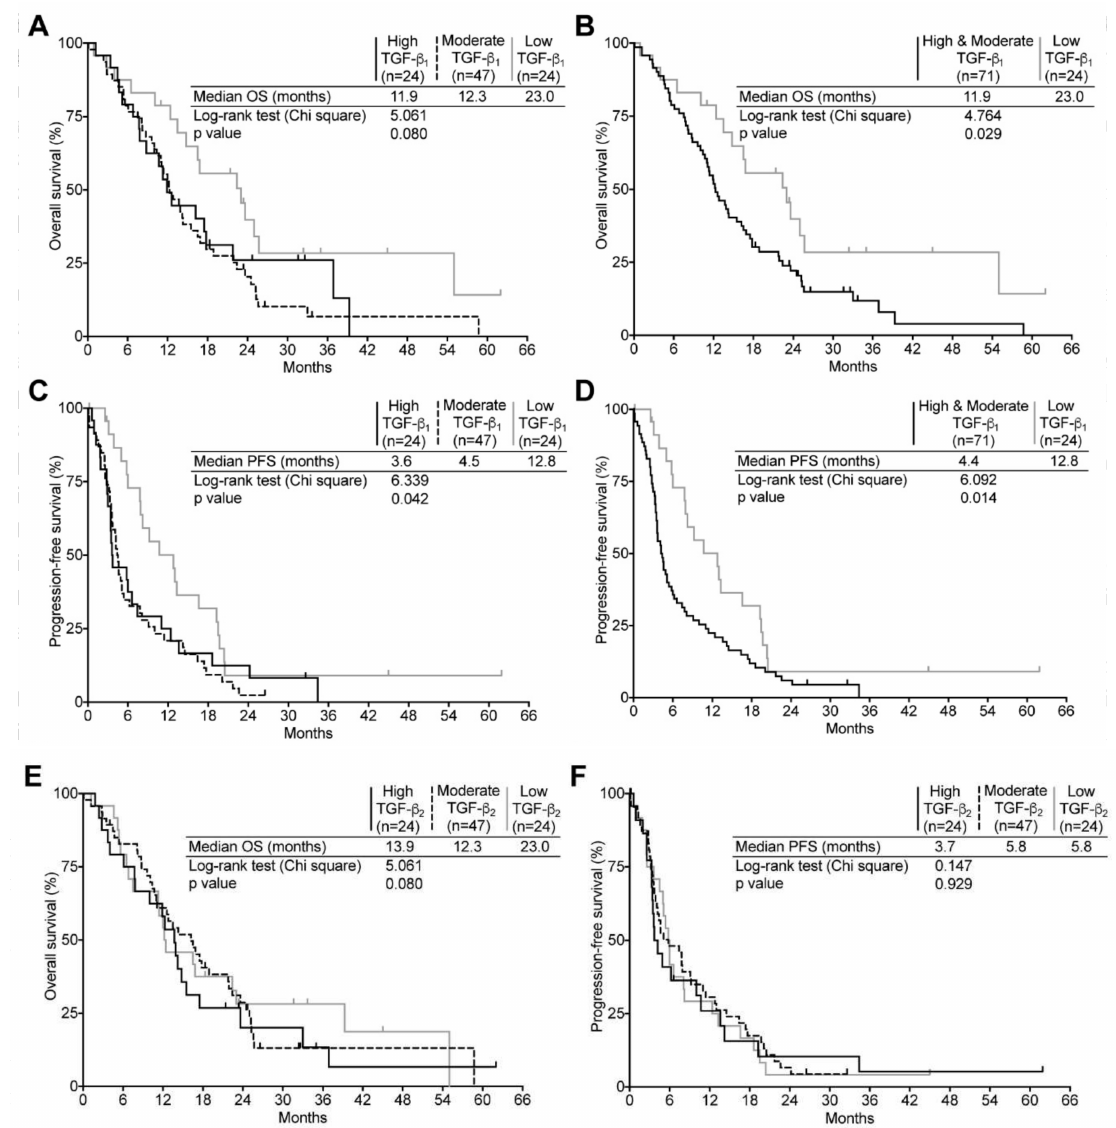
Figure 4. Correlation of TGF- β 1 and TGF- β 2 expression level with newly diagnosed GBM patient outcome. Kaplan–Meier estimates of overall survival in newly diagnosed GBM according to three ( A ) high, black line; moderate, dashed line; low, gray line and two ( B ) high + moderate, black line; low, gray line TGF- β 1 expression subgroups. Kaplan–Meier estimates of progression-free survival in newly diagnosed GBM according to three ( C ) high, black line; moderate, dashed line; low, gray line) and two ( D ) high + moderate, black line; low, gray line subgroups of TGF- β 1 expression. Kaplan–Meier estimates of overall survival ( E ) and progression-free survival ( F ) according to three subgroups of TGF- β 2 expression (high, black line; moderate, dashed line; low, gray